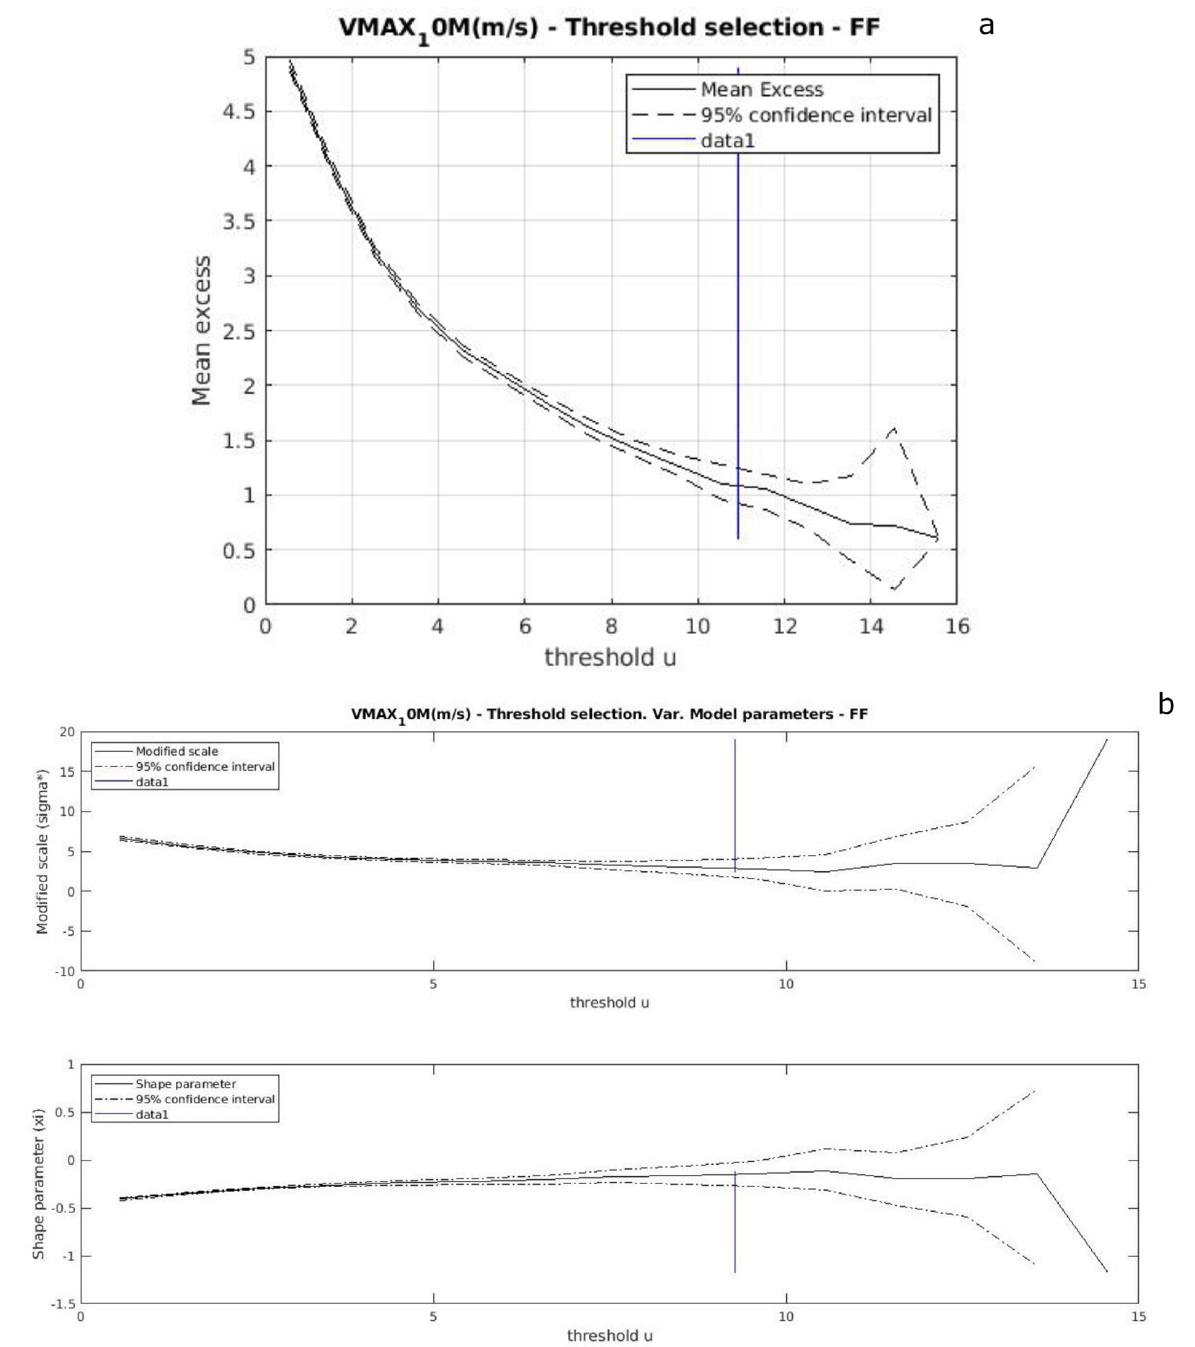
Figure A3. Graphs for the identification of the threshold for POT analysis of wind data for the historical period reference (2050–2080). ( a ) Graph of the “mean residual life” as a function of the threshold u . ( b ) Graphs of model parameters ( σ * e ξ , respectively) for evaluating their stability with the variation of the threshold u.